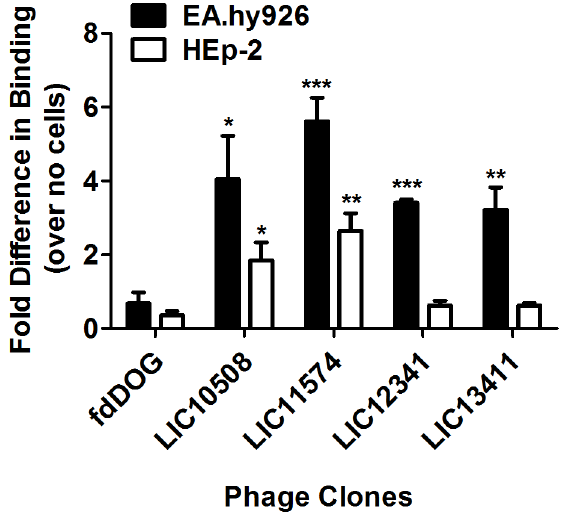
Figure 2. Selected phage clones bind to endothelial and epithelial cells. Individual phage clones ( , 10 10 ) were added with confluent endothelial EA.hy926 or epithelial HEp-2 monolayers, or to wells containing cell medium only for 2 hr at 37 u C under 5% CO 2 . Phage attachment was quantified by ELISA using an anti-M13 (fd phage coat) antibody. Vector phage clone fdDOG [37] serves as a negative control. Binding is expressed as fold difference in the absorbance between monolayers vs. wells containing medium alone. Results are expressed as means 6 standard errors, representative of at least two independent experiments repeated in quadruplicate. Error bars represent standard error while asterisks (*) indicate significant difference in attachment of candidate adhesins to cells compared to fdDOG (two-tailed t- test, * P , 0.05, ** P , 0.01, *** P , 0.001).